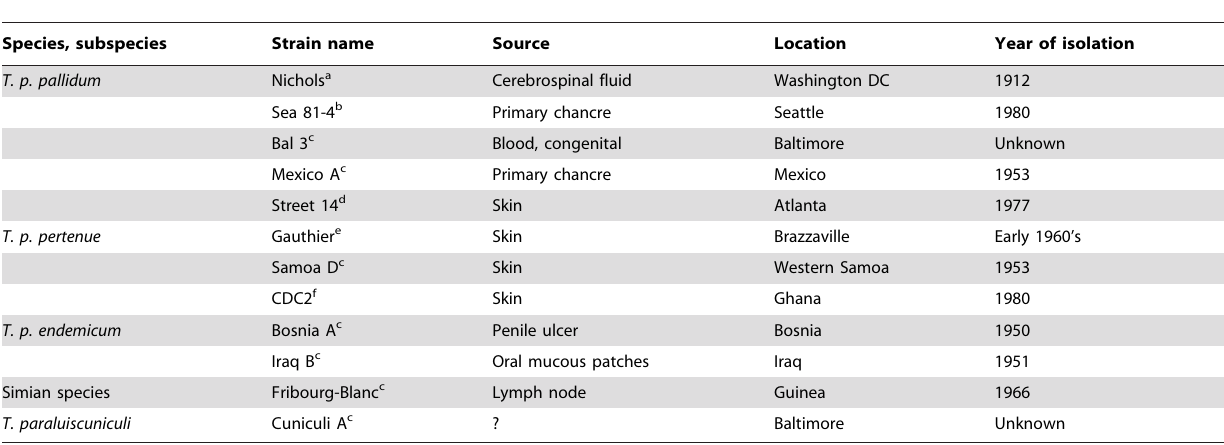
Table 1. Treponemal strains reported in this